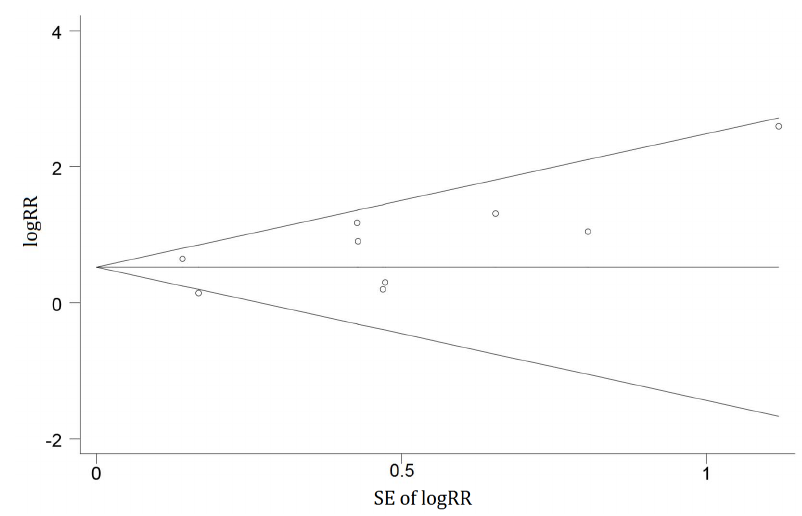
Figure 3. Funnel plots with 95% CI for AT1R-Abs and acute rejection (AR). RR, relative risk; SE, standard error.